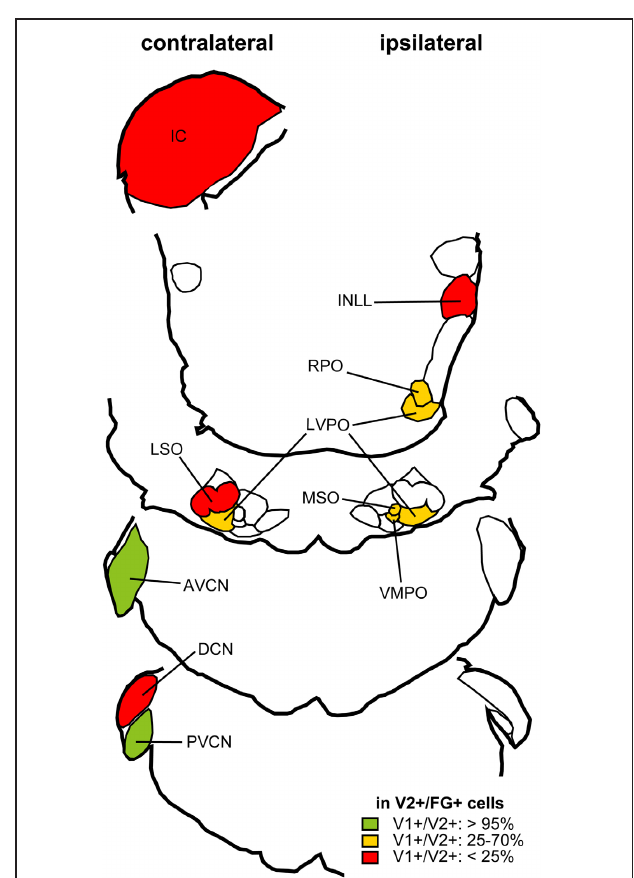
FIGURE 5 | Summary of distribution of retrogradely labeled glutamatergic cells after an injection of FG into the IC. Percentage of neurons positive for FG and VGLUT2 that co-localize VGLUT1 calculated from three cases. Nuclei that have more than 10 mean cell count of cells positive for both FG and VGLUT2 are shown. Red: Brainstem regions where fewer than 25% of cells express VGLUT1. Green: Nuclei where more than 95% cells express VGLUT1. Orange: Nuclei where 25–70% of retrogradely labeled cells co-expressed VGLUT1. Modified from Ito and Oliver